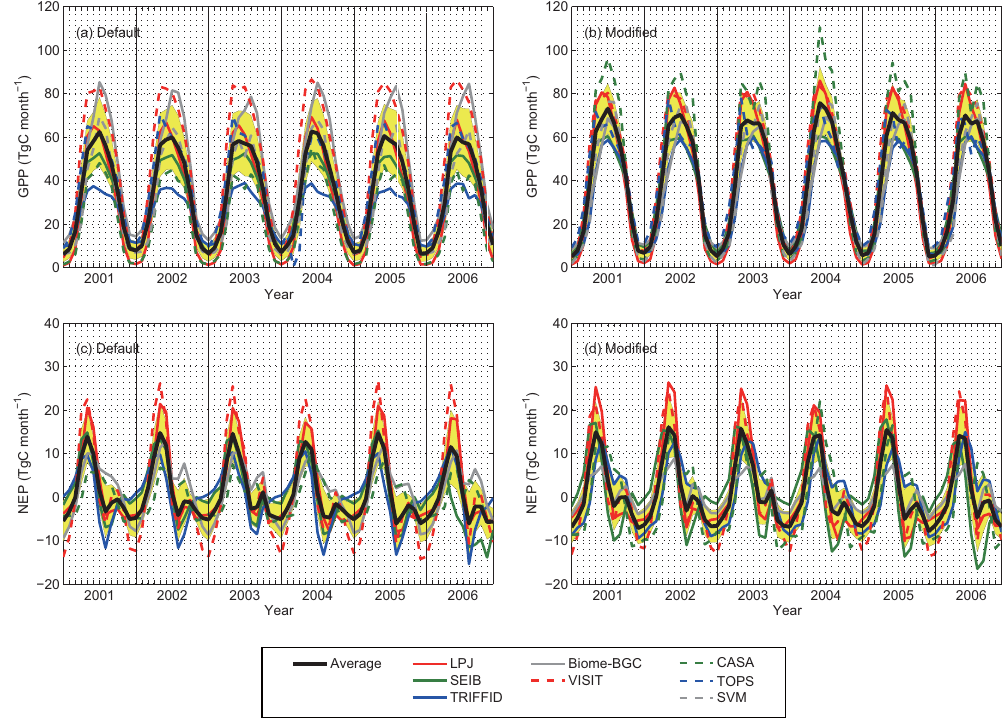
Fig. 9. Interannual variations in (a) GPP and (c) NEP based on the default models and (b) GPP and (d) NEP based on the modified models over forests in Japan. Eight (GPP) and six models (NEP) were used to calculate seasonality and averages. Yellow shows the range of the standard deviations among the